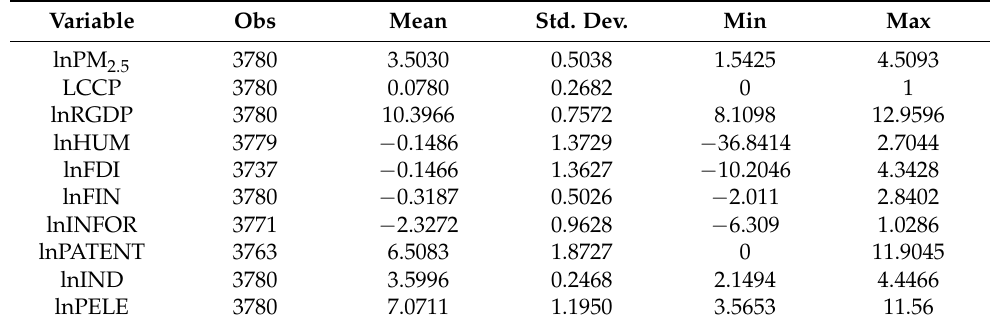
Table 1. Variable description